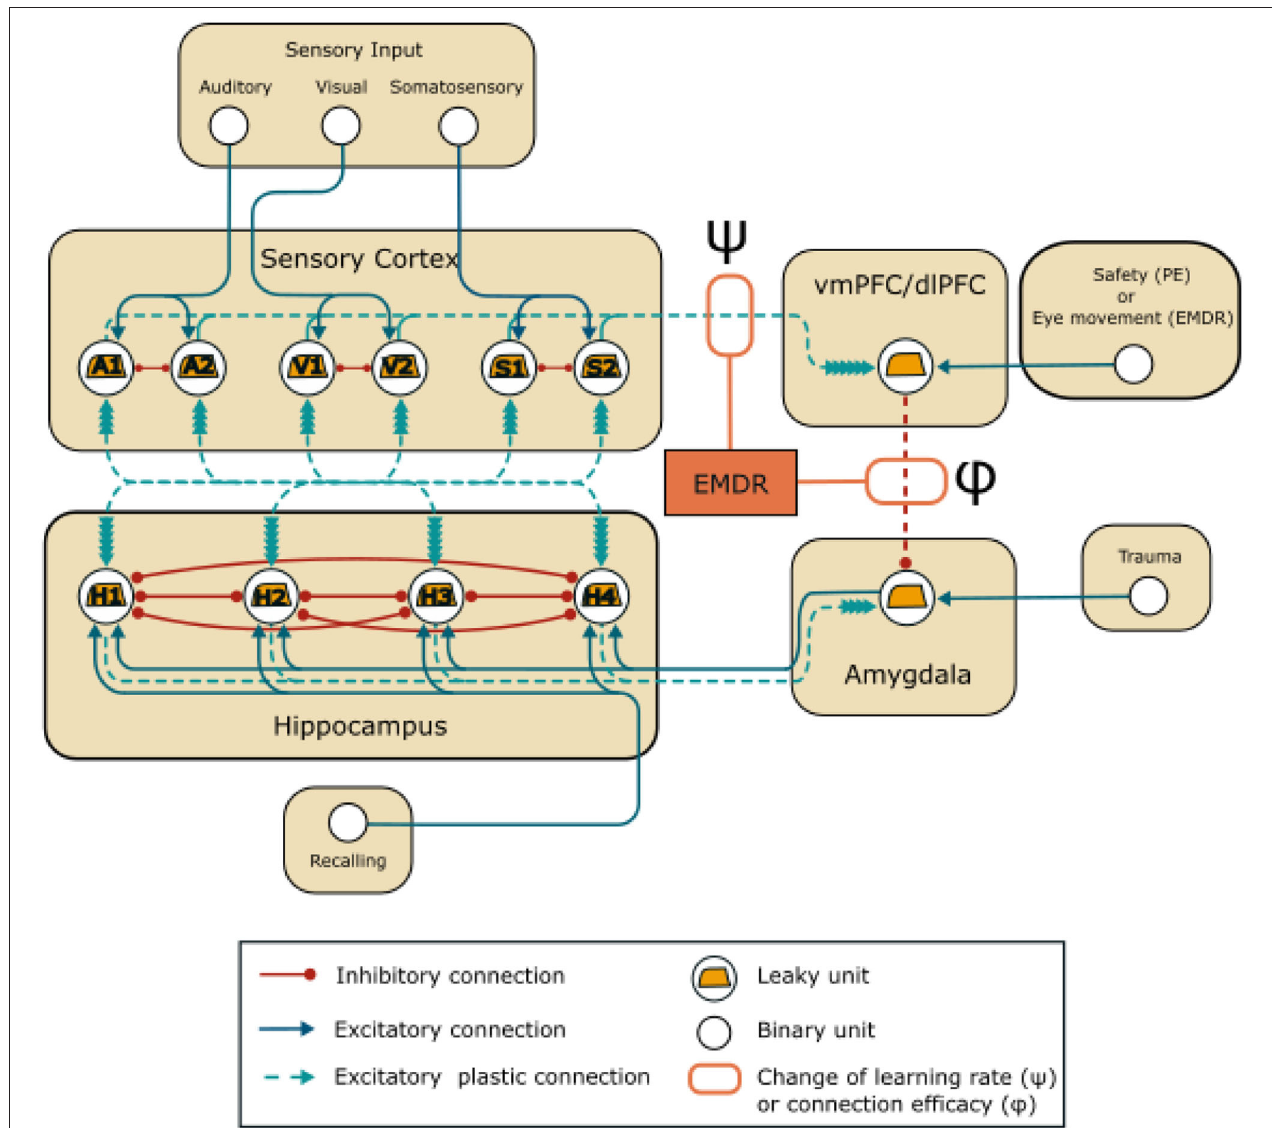
FIGURE 1 | Model architecture: units and connections of the model. EMDR acts on the strength of the inhibition from the PFC (vmPFC in PE and dlPFC in EMDR) to the amygdala through the parameter φ , and on the learning rate of the connections between the sensory units and the PFC through the parameter ψ .